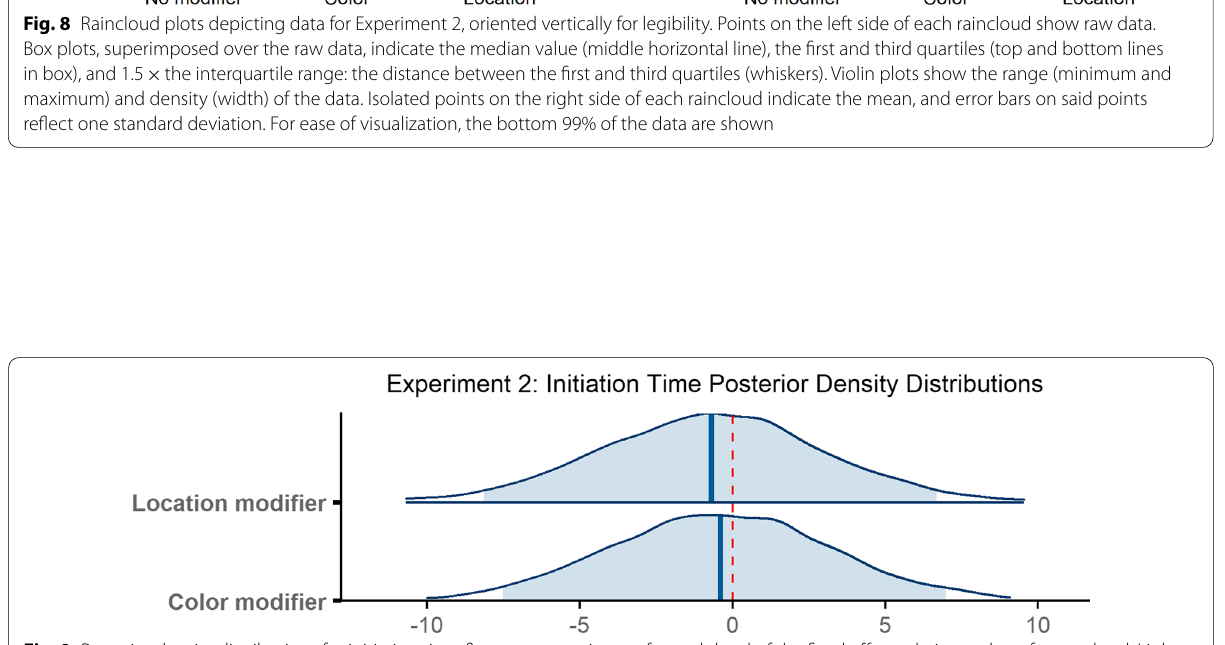
Fig. 9 Posterior density distributions for initiation time β parameter estimates for each level of the fixed effect relative to the reference level. Light blue shaded regions indicate the 95% credible interval and blue vertical lines indicate the mean of the distribution. The red vertical dashed line highlights 0 on the x axis. If the red line falls within the light blue shaded region, the estimate is not reliably different from zero and interpreted as a null